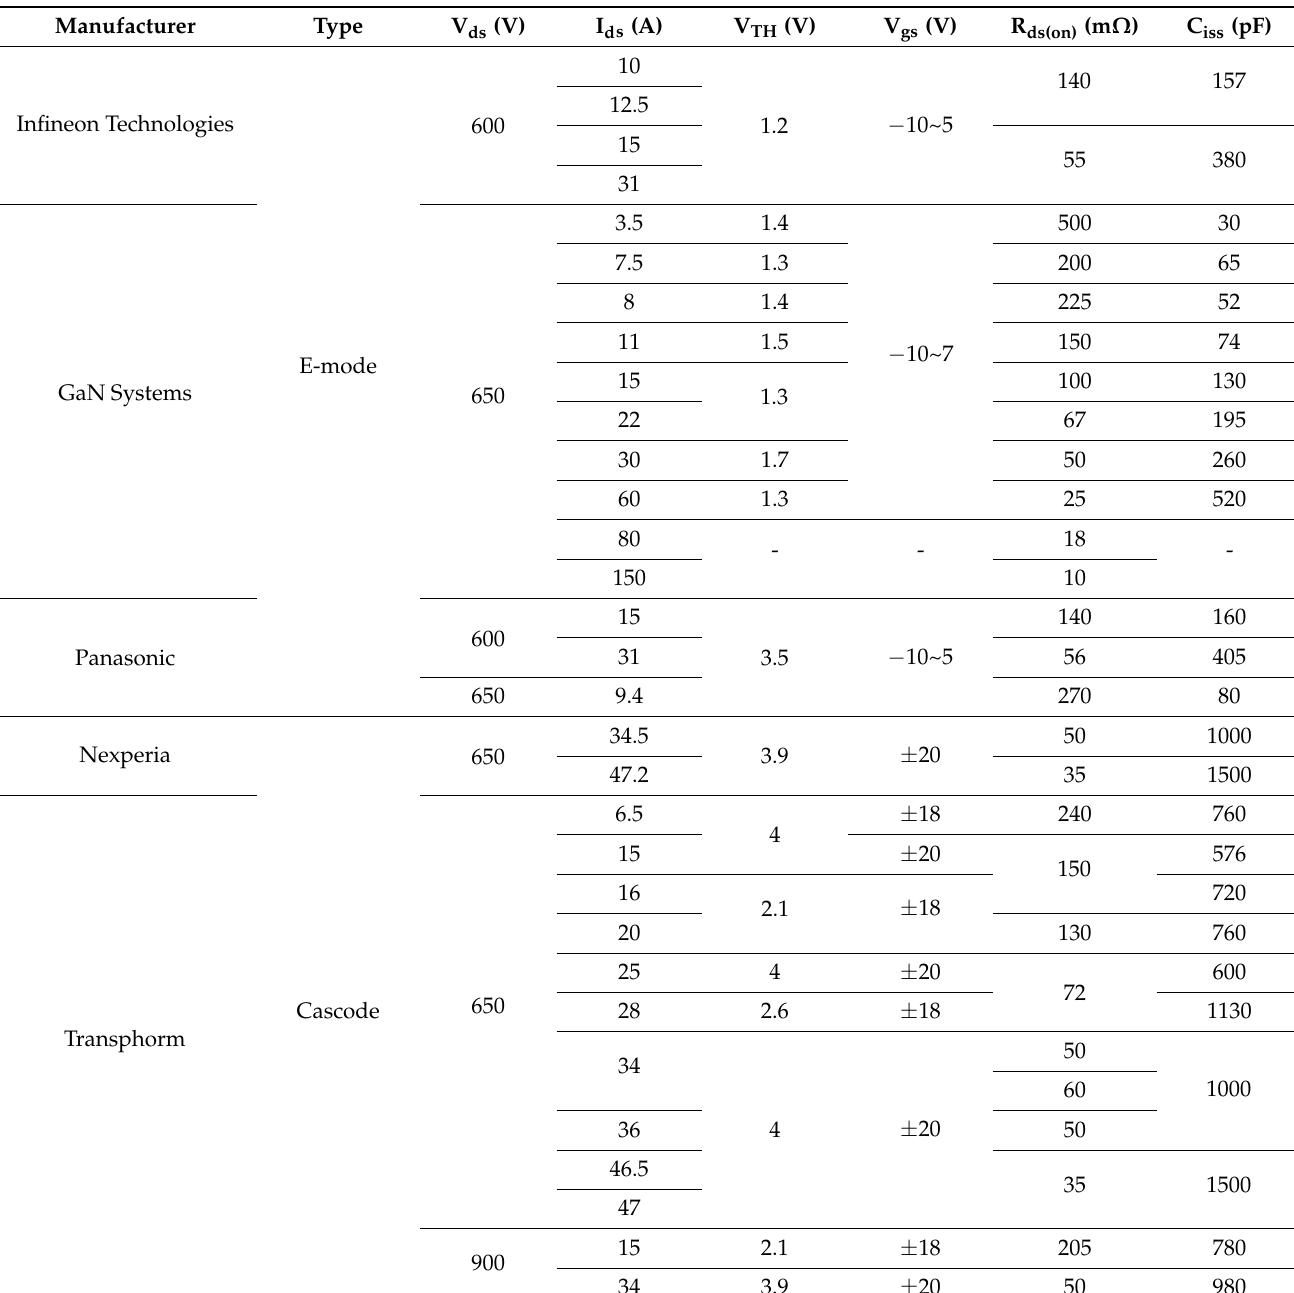
Table 3. Commercial GaN HEMTs above 600